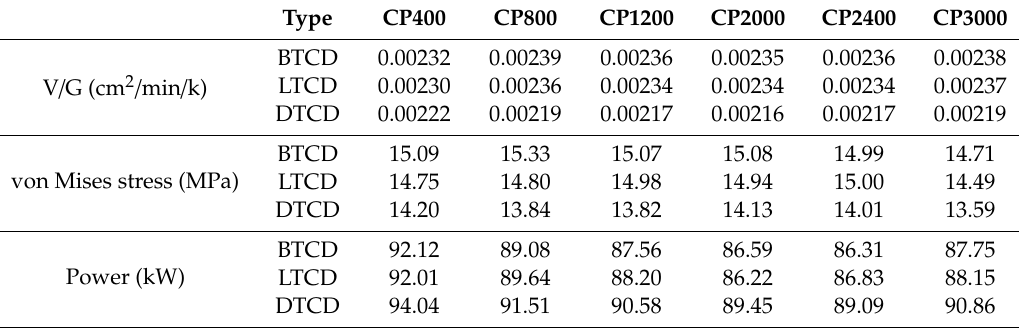
Table 3. Analysis result of the